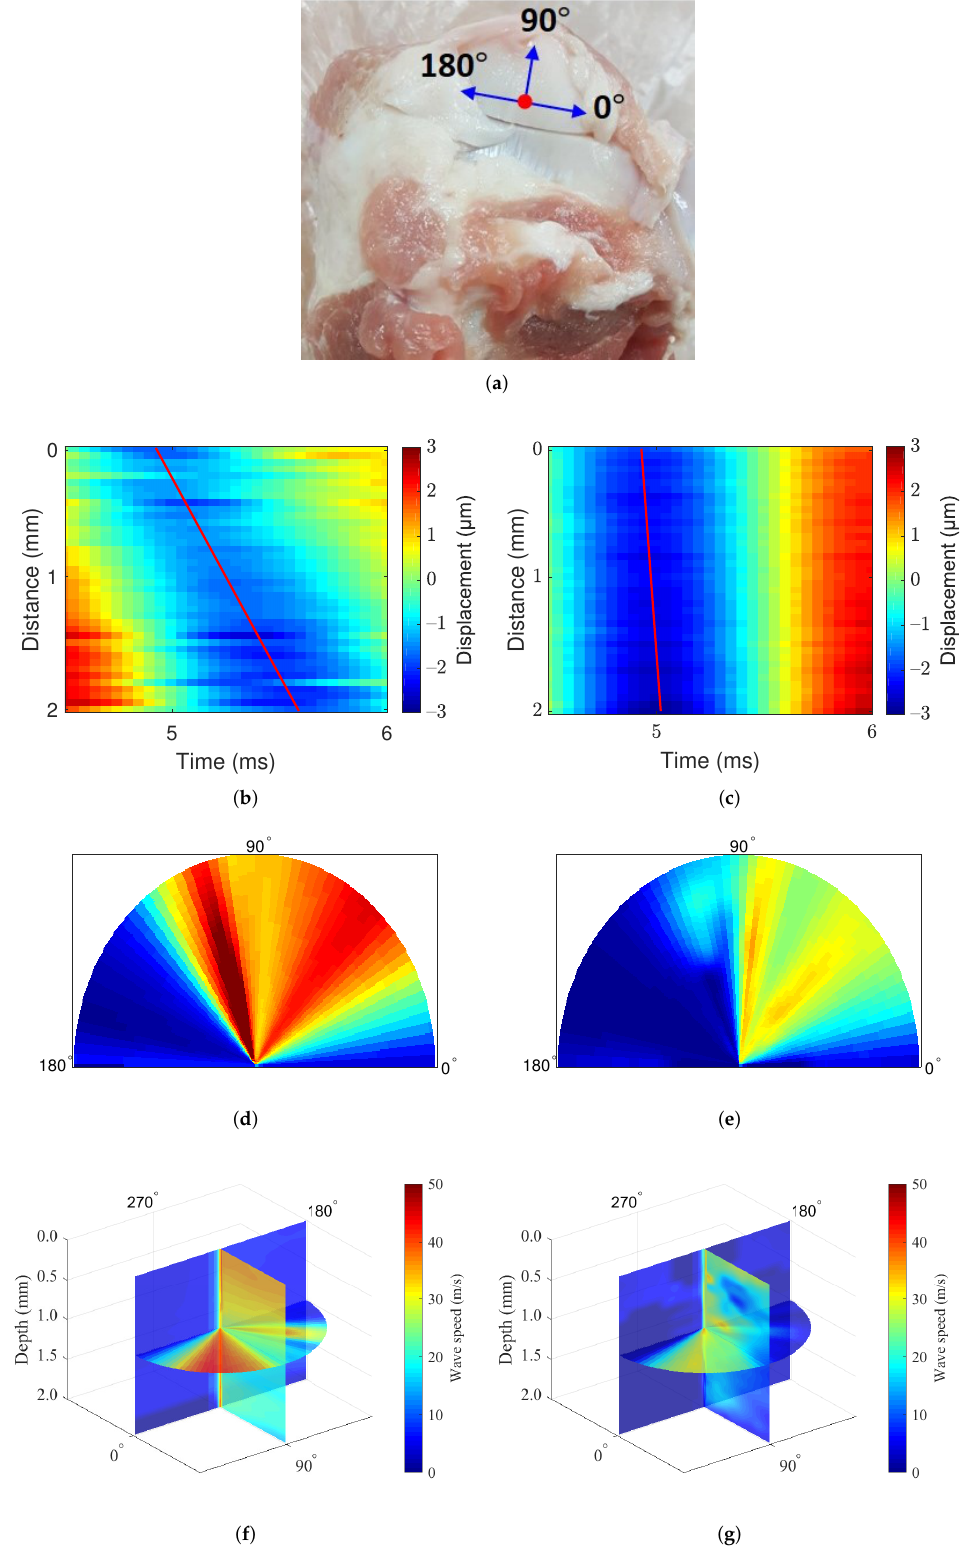
Figure 8. Cartilage image: directional dependence of the cartilage. The slope of the red line indicates the wave speed. ( a ) Cartilage image, ( b ) displacement map: circumferential direction, ( c ) displacement map: longitudinal direction, ( d ) cartilage image1: 0 mm depth, ( e ) cartilage image2: 0 mm depth, ( f ) cartilage image1: 180 ◦ , and ( g ) cartilage image2: 180 ◦ (A depth of 0 mm does not mean the surface, but the point at which the ultrasound transducer started measuring inside of the